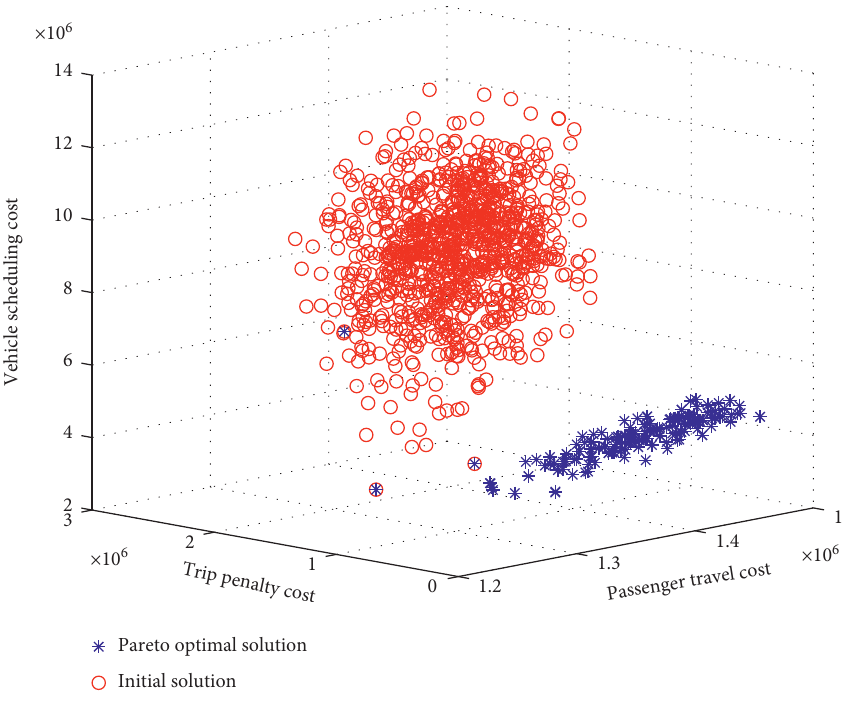
Figure 15: Pareto optimal solution set and initial solution set of the integrated model.